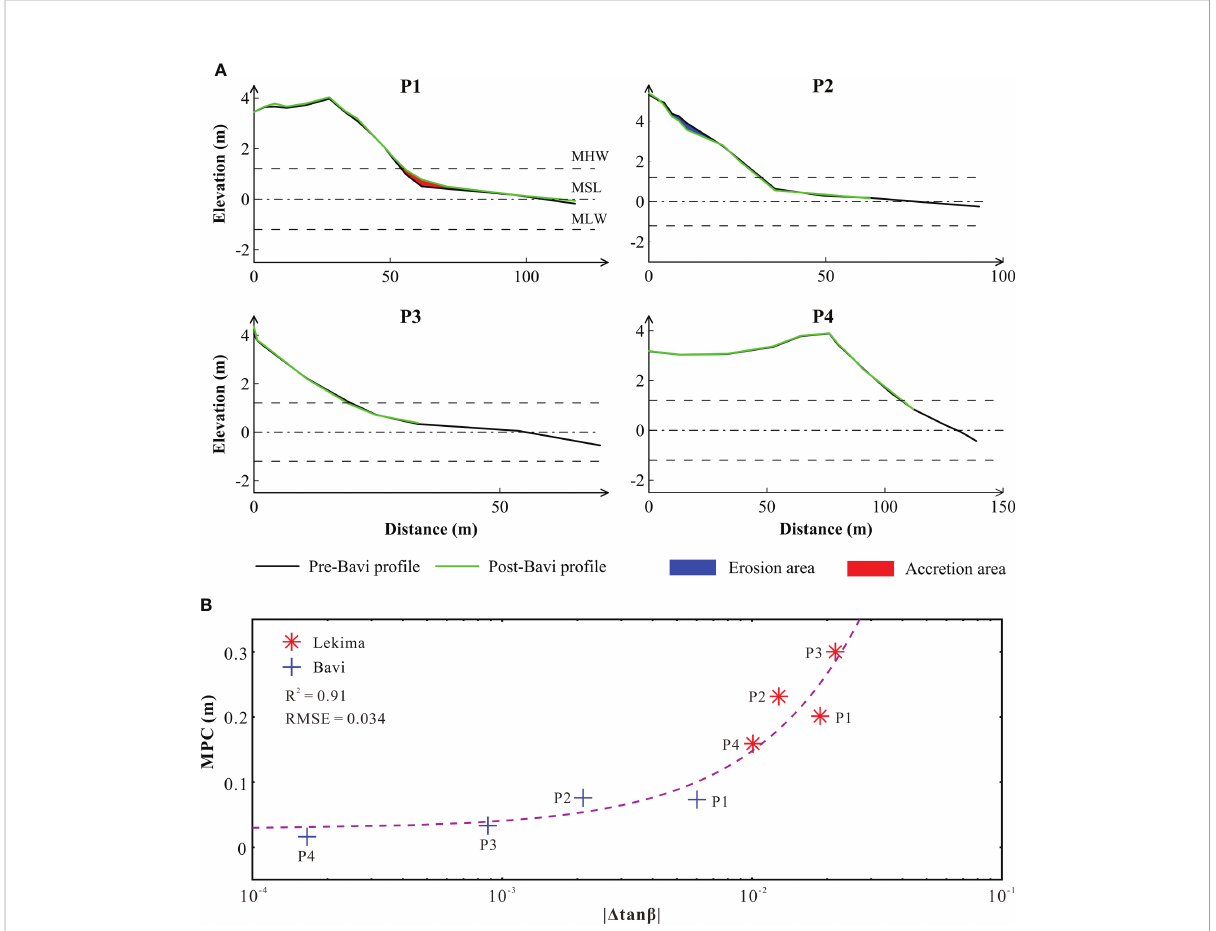
FIGURE 5 Changes in beach pro fi les before and after Bavi (A) . Relationship between beach slope and mean pro fi le change (MPC) induced by two TCs (B) , the dashed purple line is the fi tted